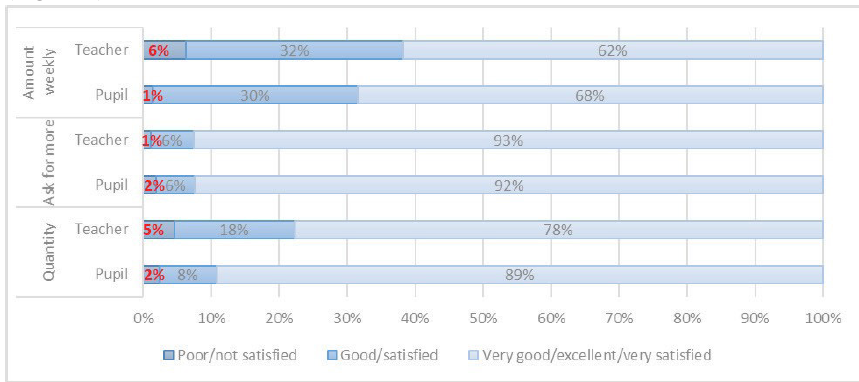
Fig. 4: Perception of Quantity-Related